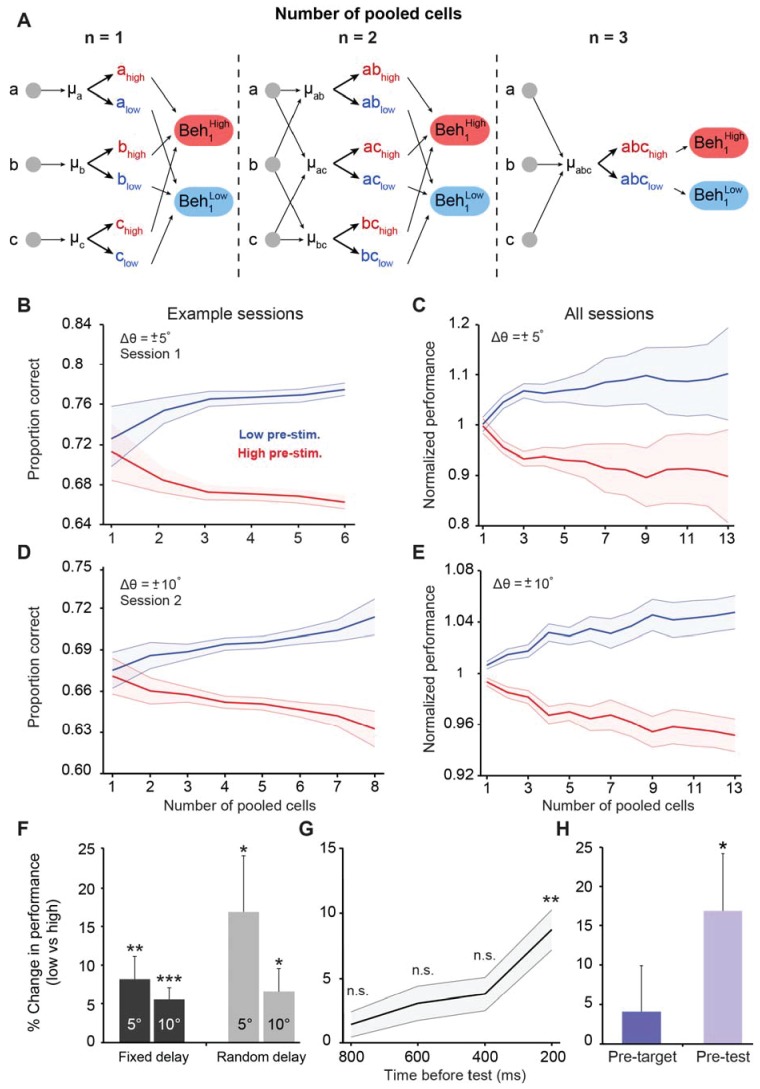
Cortical state influences behavioral performance in an orientation discrimination task.(A) Diagram depicting our analysis linking neuronal populations and behavior (examples provided for n = 1, 2, and 3 cells). For n = 1, we computed the mean pre-stimulus firing rate individually for each neuron (μA, μB, and μC) and then calculated the average behavioral performance in the low and high pre-stimulus trials, averaged across the three cells for each group (Beh1low and Beh1high). For n = 2, we computed the mean normalized pre-stimulus activity for each pool of 2 cells (μAB, μAC, and μBC), then divided the trials into high and low groups, and calculated the average behavioral performance in the low and high pre-stimulus trials (Beh2low and Beh2high). For n = 3, we computed the mean normalized response for all three cells (μABC) and then split the trials to compare behavioral performance between the low and high pre-stimulus groups (Beh3low and Beh3high). (B–E) Behavioral performance is modulated by the ongoing population activity; a single session (panels B and D); all sessions (panels C and E). Behavioral performance associated with each ongoing activity state in each session was normalized by dividing the performance in each state by the average session performance (irrespective of pre-stimulus state). The pre-stimulus state was determined based on the pooled activity of neural populations of varying size (based on the method in panel A). The difference in discrimination performance between low and high pre-stimulus response states was greater when population size increases. Panels 3B and C correspond to orientation differences between target and test of ±5°; Panels 3D and E correspond to orientation differences between target and test of ±10°. ‘All sessions’ in panel C includes data from monkeys 1 and 2 (n = 24 sessions). ‘All sessions’ in panel E includes data from monkeys 1, 2, and 3 (n = 42 sessions). Error bars represent s.e.m of session performance for each population size. (F) Behavioral improvement in the low vs. high pre-stimulus conditions is present for both the fixed and random delay conditions for the ±5° and ±10° orientation differences (*p<0.05, **p<0.01, ***p<0.001; Wilcoxon signed-rank test). Results in panels F-H were obtained for a population size of 5 to include most sessions in the analysis. (G) Behavioral improvement in the low vs. high pre-stimulus state for different pre-stimulus periods. The x-axis represents the time relative to the onset of the test stimulus. Pre-stimulus state was assessed based on the pre-stimulus interval in 200 ms steps (during the delay period). The improvement in discrimination performance in the low pre-stimulus state occurs only during the 200 ms period before test presentation. (**p<0.01; n.s. = non significant; Wilcoxon signed-rank test). Error bars represent s.e.m. (H) Neuronal activity in the pre-test interval influences behavior to a larger extent than that in the pre-target interval (*p<0.05; n = 13 sessions from the random delay experiment; the fixed delay data was not included because the pre-target interval was too small, that is, 100 ms).